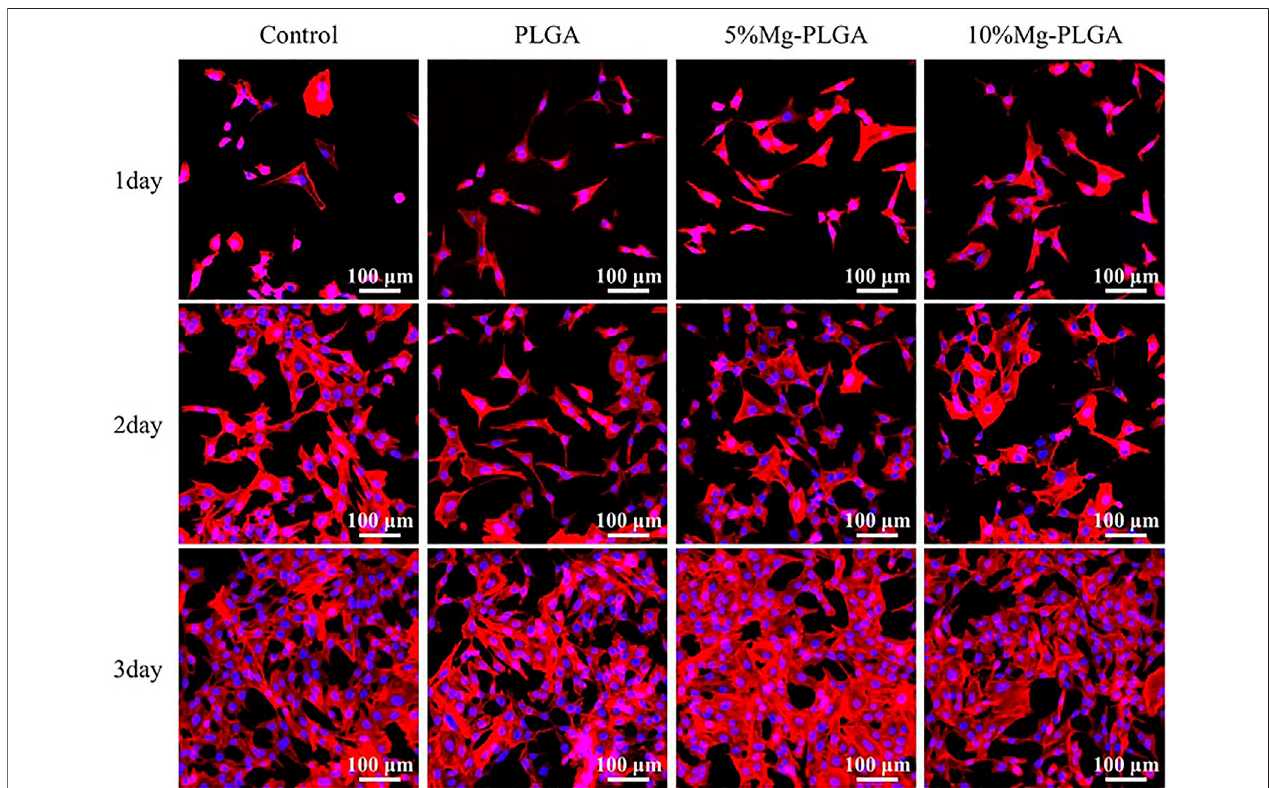
FIGURE 6 | It showed the cytoskeletons and the nucleus of the MC3T3-E1 cells cultured on samples for 1, 2, and 3 days. It indicated that there was no signi fi cant difference for cellshape and number betweengroups. The samples inPgroup, P5%Mg group, and P10%Mg group werefavorableto initialattachmentand spreading of